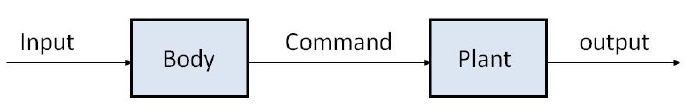
Figure 1. Open-loop control process flowchart.